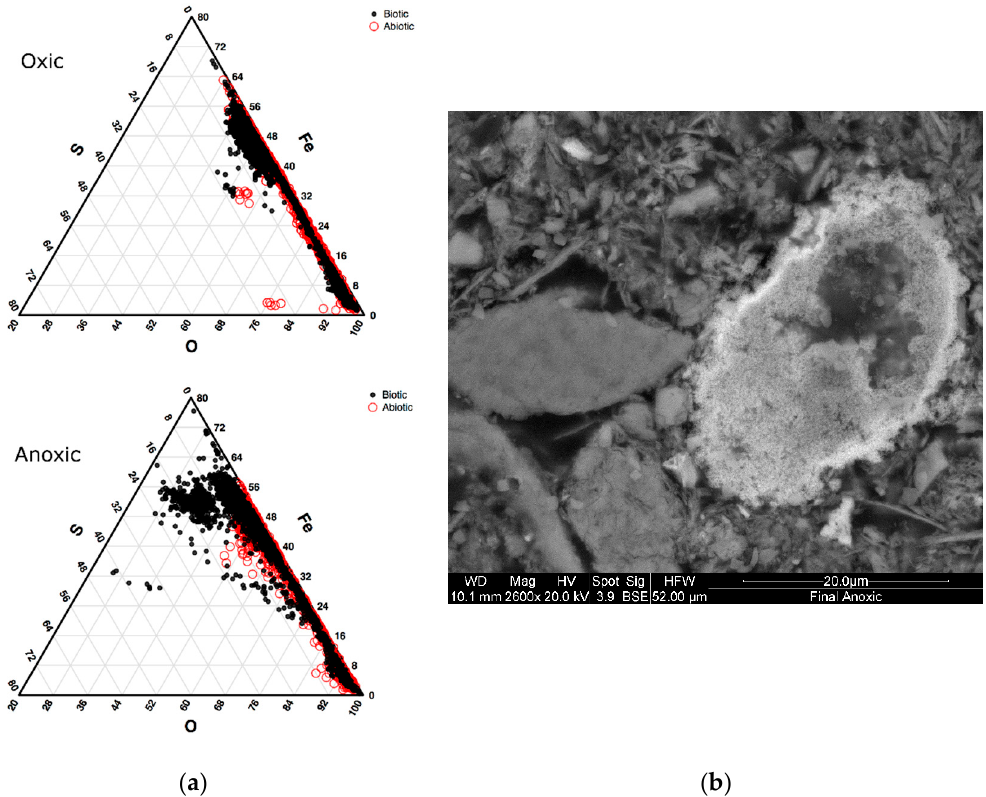
Figure 1. SEM analysis of sludge collecting from final sediment samples; ( a ) Ternary plot shows the distribution of Fe, S, and O elemental concentrations. The oxic incubations are shown on the top figure and anoxic on the bottom, with data from the biotic incubations represented by solid black circles and the abiotic data represented by open red circles; ( b ) Example of a high sulfur and iron particle showing submicron microcrystals in a pre-framboidal texture.